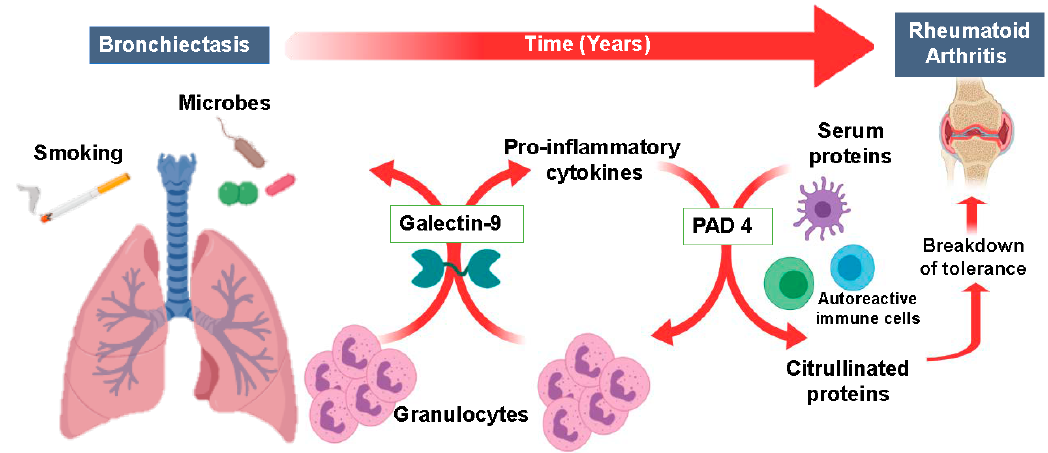
Figure 7. Galectin-9 is a possible promoter of immunopathology in rheumatoid arthritis by activating granulocytes. A possible scenario for the pathophysiological process of citrullinated peptide generation (via lung disease) through Gal-9 resulting in the development of RA. Following inflammation in the lung and infiltration of granulocytes, release of Gal-9 aids resolution of pro-inflammatory cells, leading to PAD-4 activation in granulocytes. Subsequently, this can lead to citrullination of intracellular proteins (as in vitro demonstrated in the current study) that upon release from cells can trigger and autoimmune response in immune cells leading to break down of tolerance over time.